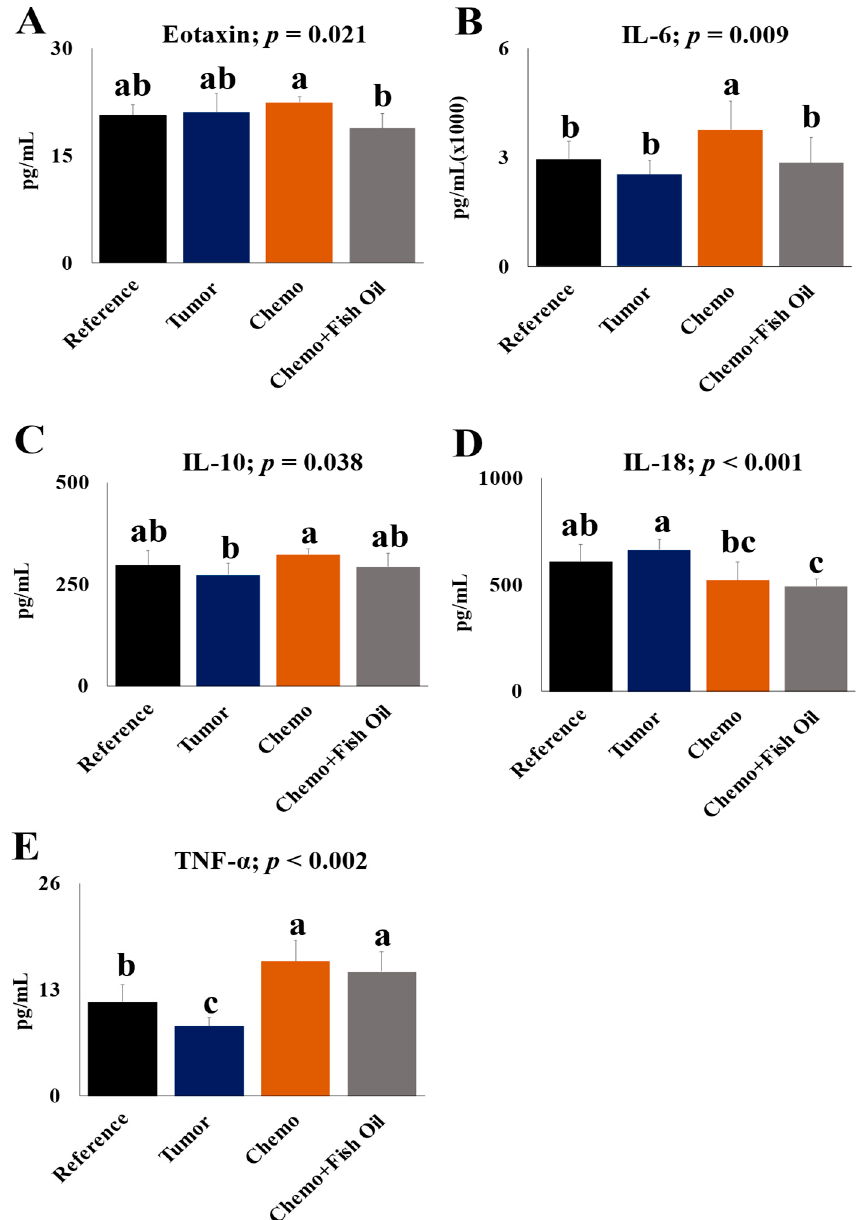
Figure 6. Hepatic eotaxin ( A ); IL-6 ( B ); IL-10 ( C ); IL-18 ( D ) and TNF- α ( E ). Significant